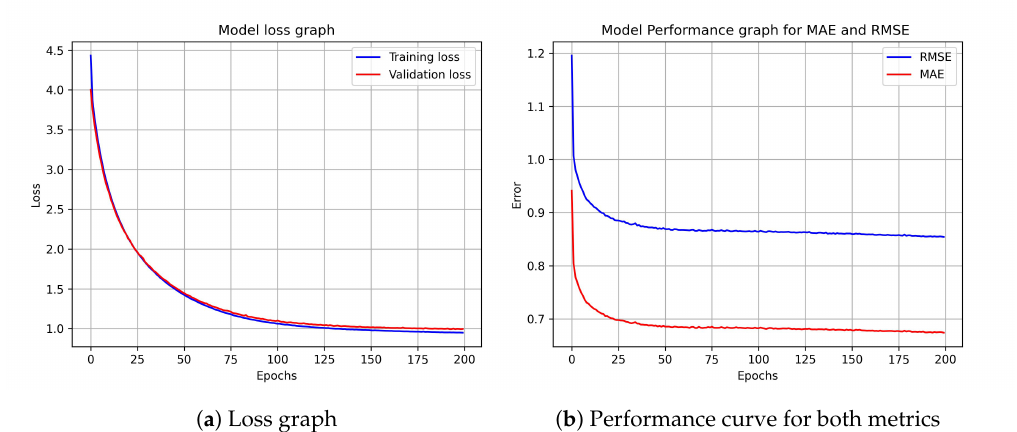
Figure 4. A three-hidden-layer model for the ML-100K dataset. In Part ( a ), we have the training and validation loss curve versus a number of training epochs, and in Part ( b ), we have the performance results. As observed, the method converges.